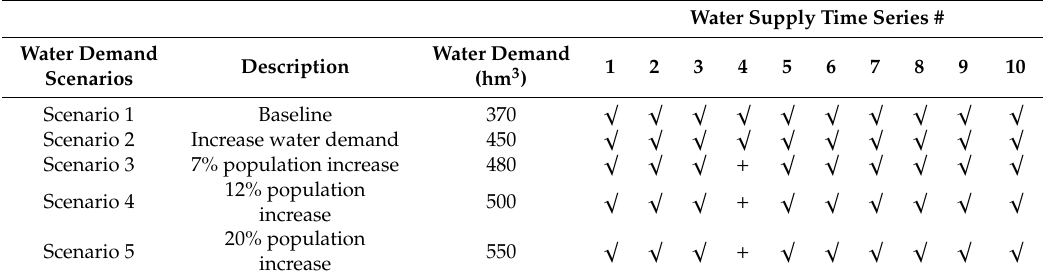
Table 4. Water demand scenarios assessment based on the water supply time series.